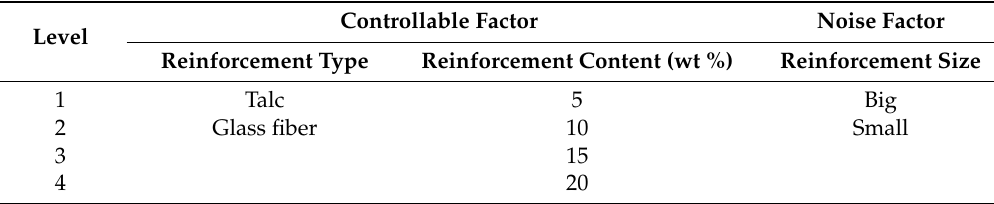
Table 1. Factors and levels of the